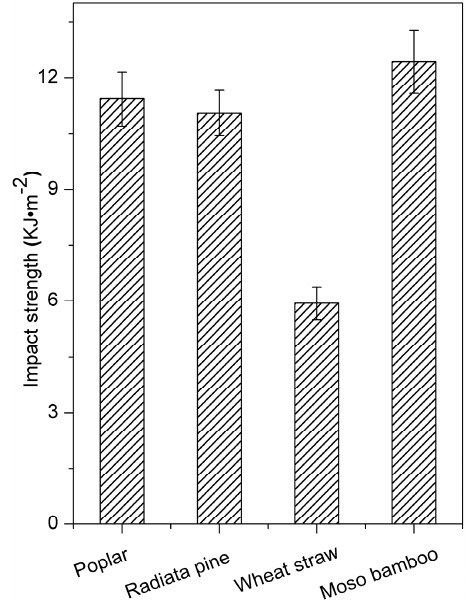
Figure 5. Impact strength of composites with different biomass species.